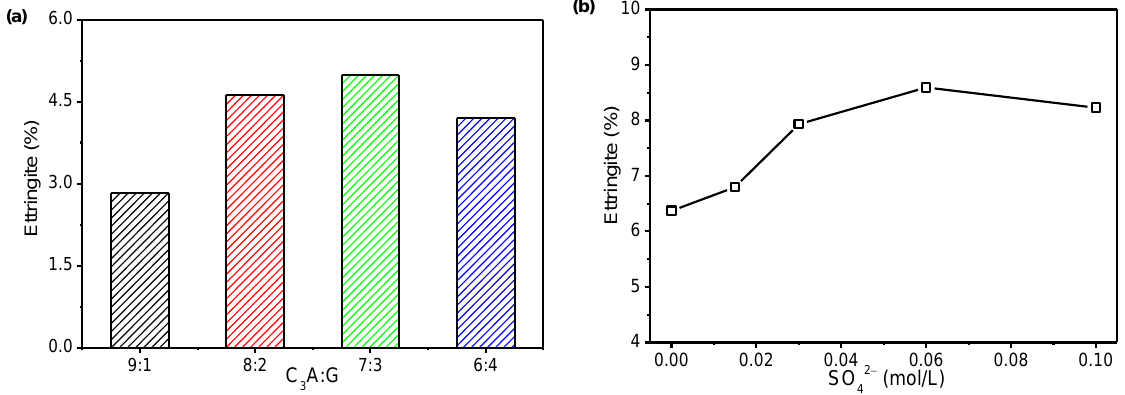
Figure 1. Amount of precipitated ettringite at 20 min: ( a ) effect of C 3 A/G; ( b ) effect of SO 4 2− concen- tration in simulated solution. concentration in simulated solution.